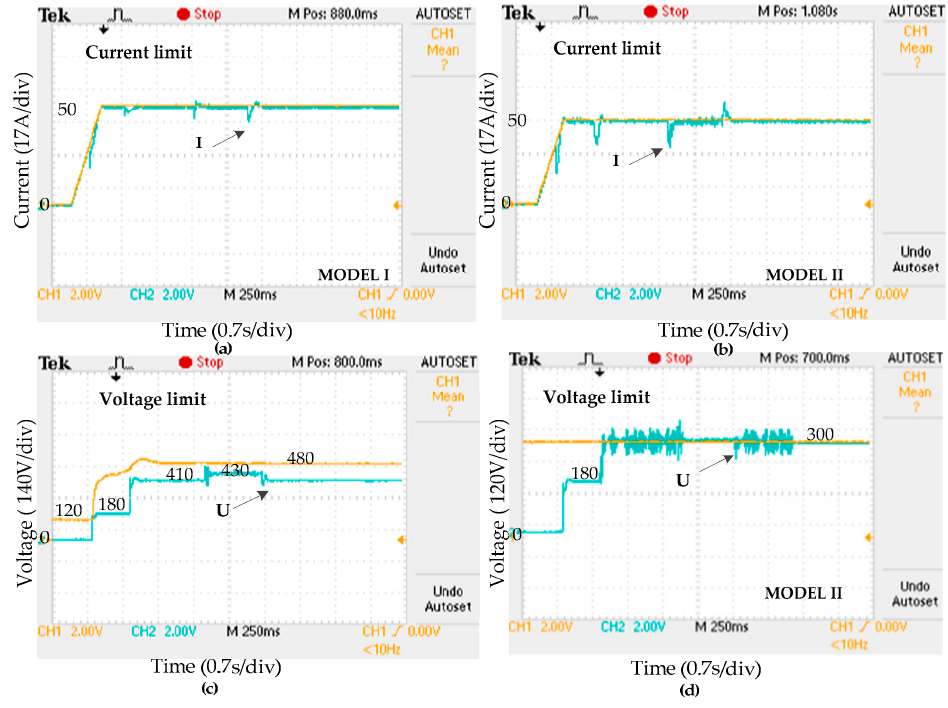
Figure 25. Response of current and voltage amplitude to the speed reference step variation when torque command is 190 Nm. ( a ) actual current and the current limit of Model I; ( b ) actual current and the current limit of Model II; ( c ) actual voltage and the voltage limit of Model I; ( d ) actual voltage and the voltage limit of Model II.